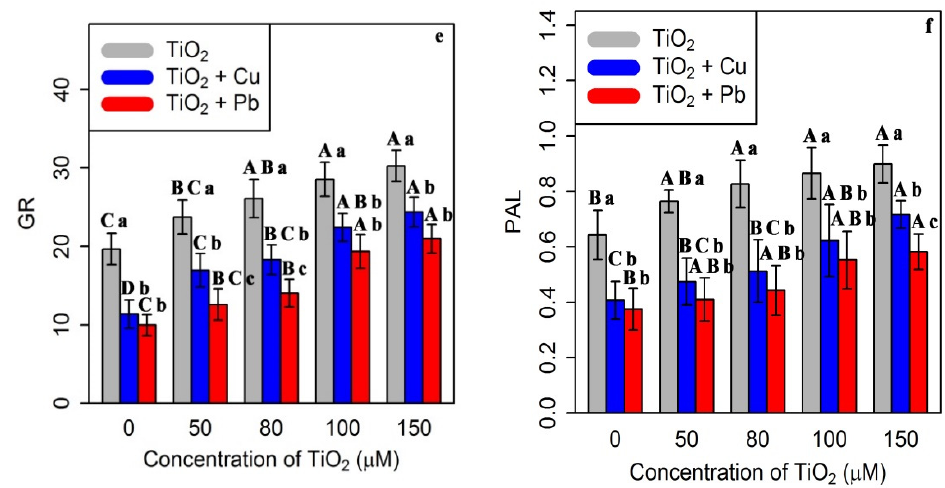
Figure 1. Impacts of TiO 2 NP levels on the antioxidant enzyme activities (SOD ( a ), POD ( b ), CAT ( c ), APX ( d ), GR ( e ), and PAL ( f )) of A. pygmaea L. with 100 µ M Cu and 100 µ M Pb. The treatments contained various concentrations of TiO 2 NPs alone or in combination with 100 µ M Cu and 100 µ M Pb. The capital letters show statistically significant differences across various levels of TiO 2 NPs alone or in combination with 100 µ M Cu and 100 µ M Pb (the bars with the same colors), while the lowercase letters show statistically significant differences within each concentration of TiO 2 NPs alone or in combination with 100 µ M Cu and 100 µ M Pb (the bars with different colors) according to Tukey (cid:48) s test ( p <